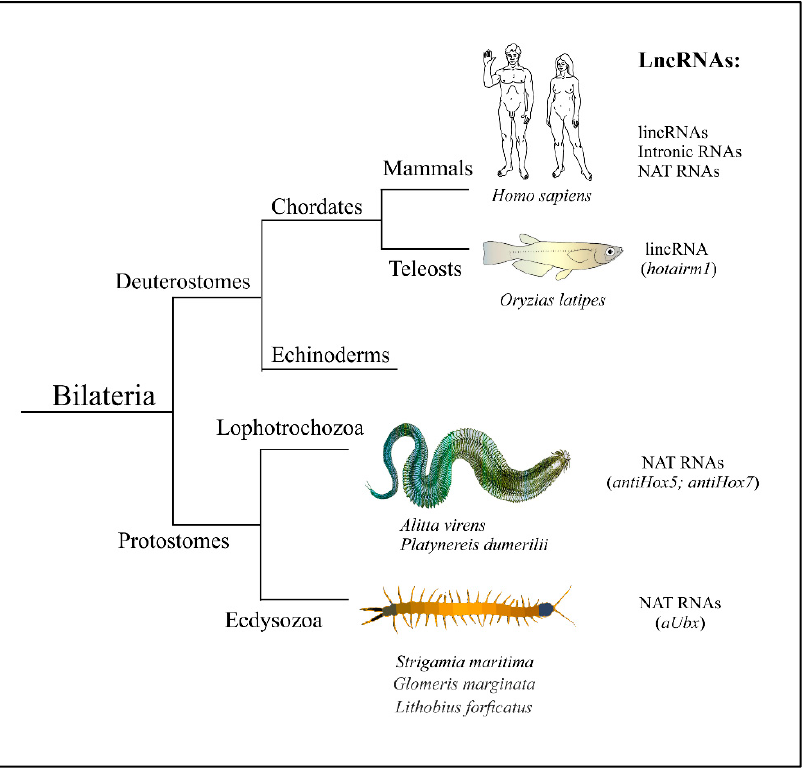
Figure 2. Hox-associated lncRNAs are found in bilateral animals belonging to three main evolutionary lineages—Deuterostomia, Lophotrochozoa, and Ecdysozoa. Individual human lncRNAs are listed in Table 1.